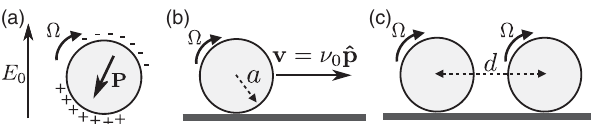
FIG. 6. Quincke rollers. (a) When applying a dc electric field E 0 to an insulating sphere immersed in a conducting fluid, a charge dipole forms at the sphere surface. When E 0 > E electric dipole makes a finite angle with the electric field causing the steady rotation of the sphere at constant angular speed Ω . (b) The rotation is converted into translation by allowing the sphere to sediment on one electrode. When isolated, the resulting Quincke rotor rolls without sliding at constant speed: ν 0 ð 0 Þ ¼ a Ω . (c) When two colloids rolling in the same direction are close to each other, the lubrication torque acting on the two spheres separated by a distance d scales as log ð d − 2 a Þ and hinders their rolling